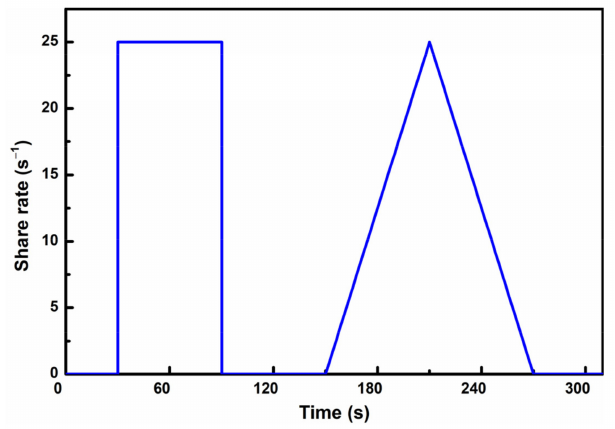
Figure 4. Test procedure for rheological